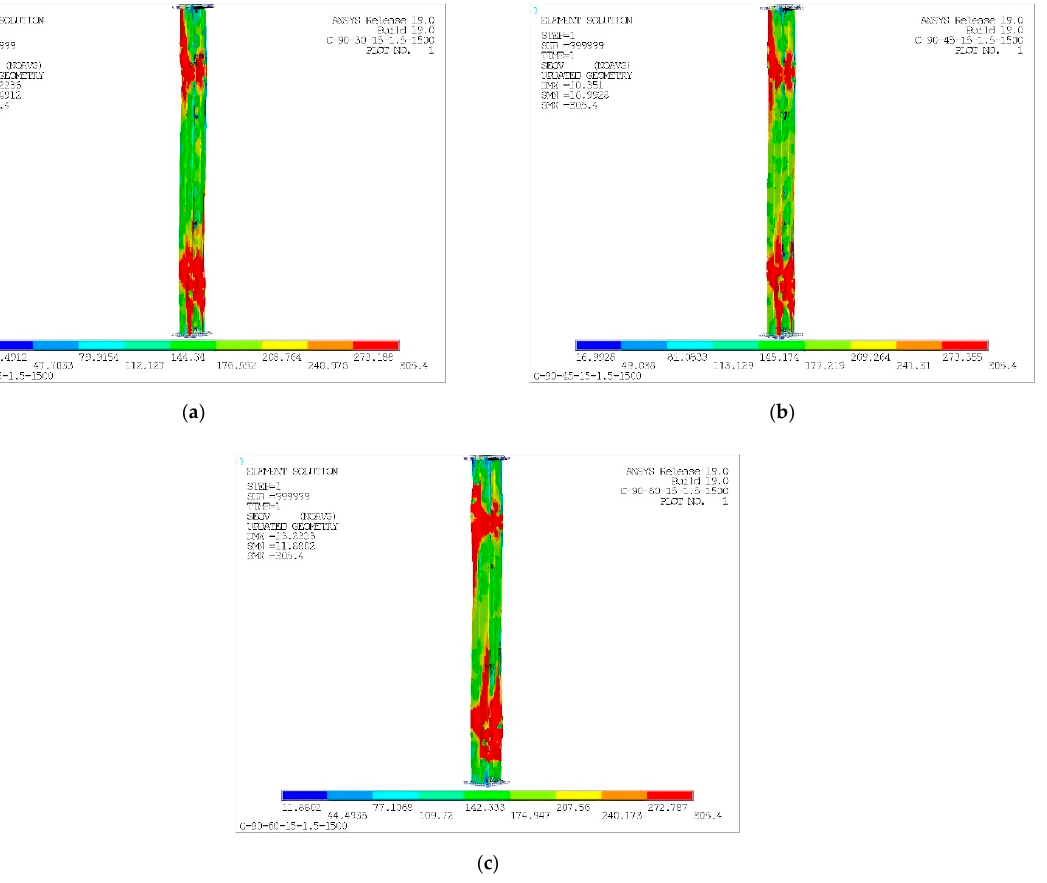
Figure 14. Stress distortions of the combined columns with different width to thickness ratios of